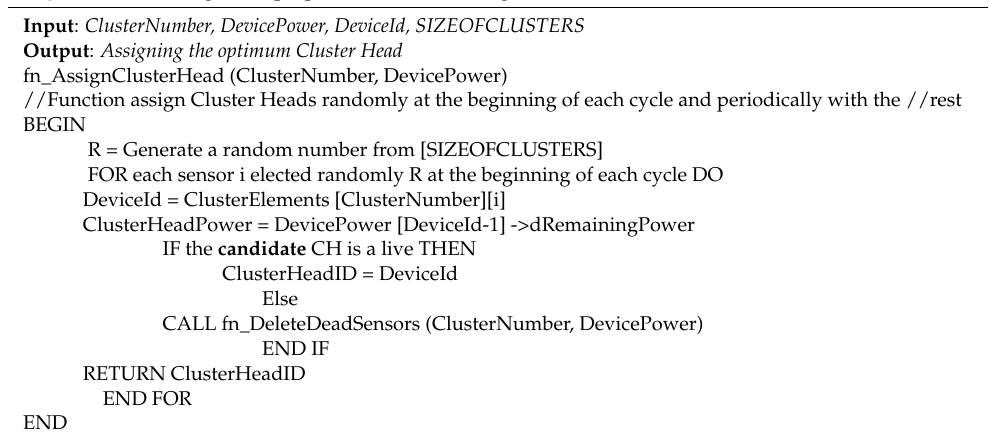
Algorithm 1 Working of the proposed method in a single